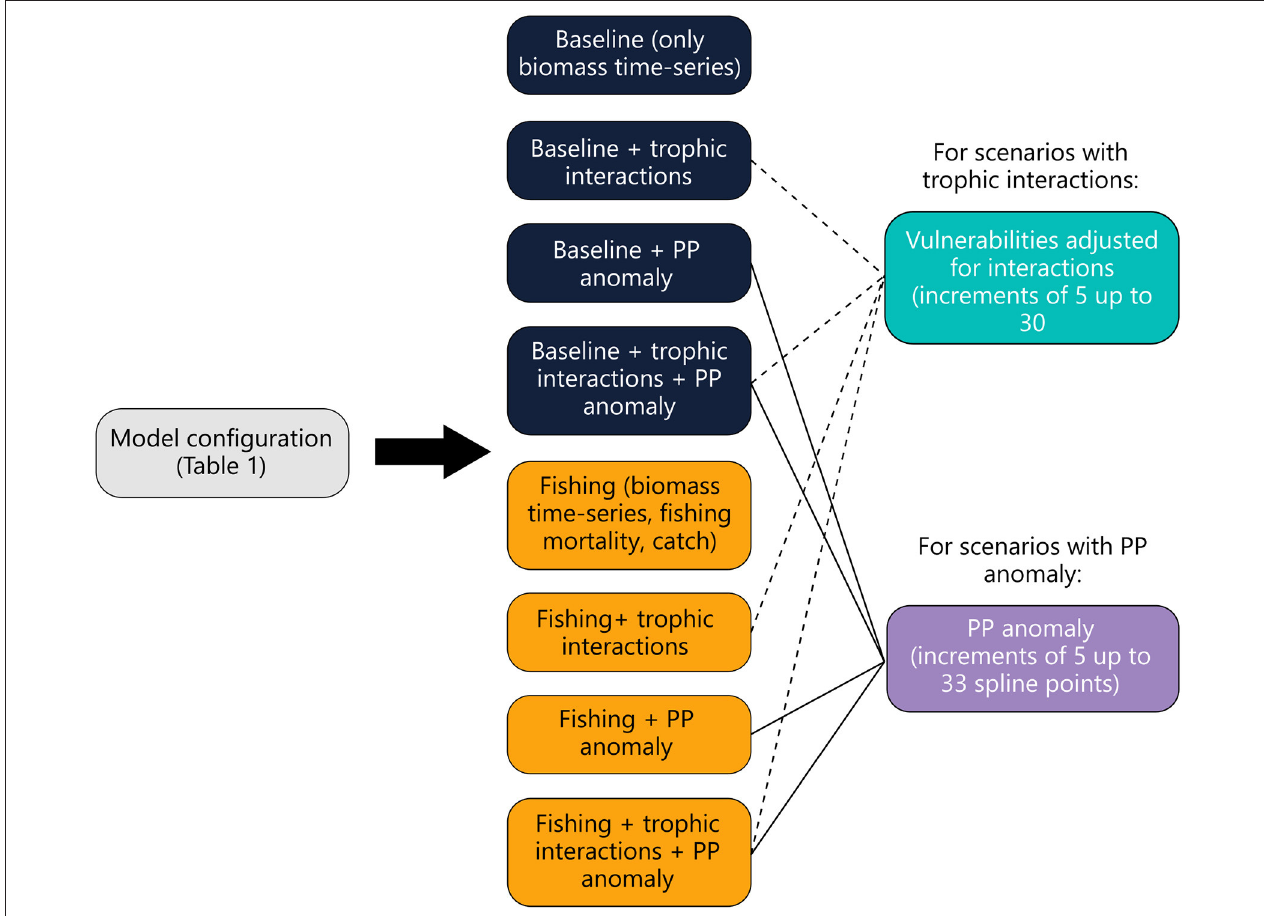
FIGURE 3 | Diagram showing how Ecosim was used to calibrate the model. Eight scenarios were run (dark blue and yellow) for each model configuration in Table 1 . Baseline scenarios (dark blue) do not include fisheries data. For scenarios including trophic interactions (blue) and PP anomalies (purple), each scenario was run by increasing the number of vulnerabilities estimated for trophic interactions and PP anomaly spline points by 5 until the maximum was reached (5, 10,